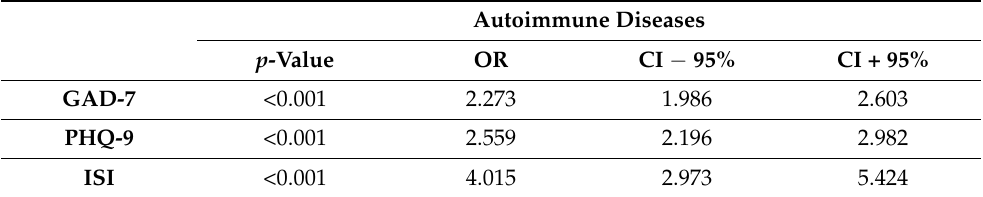
Table 4. Multivariable logistic regression model for autoimmune